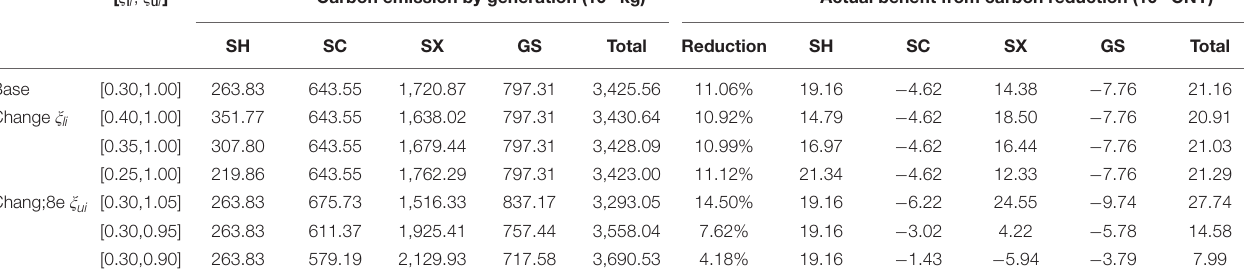
TABLE 9 | Results of the sensitivity for